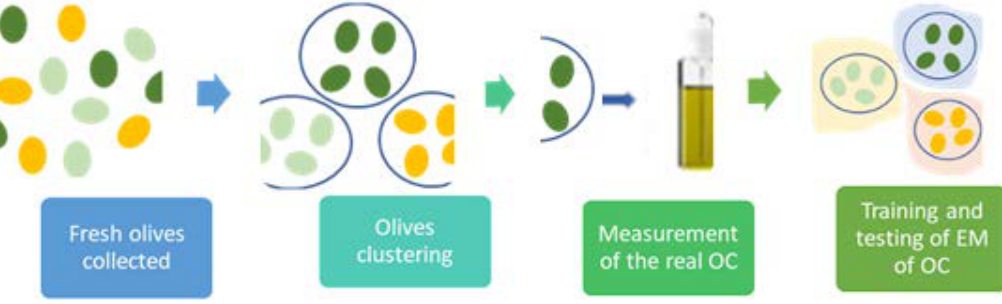
Figure 1. Sequential scheme of the study.